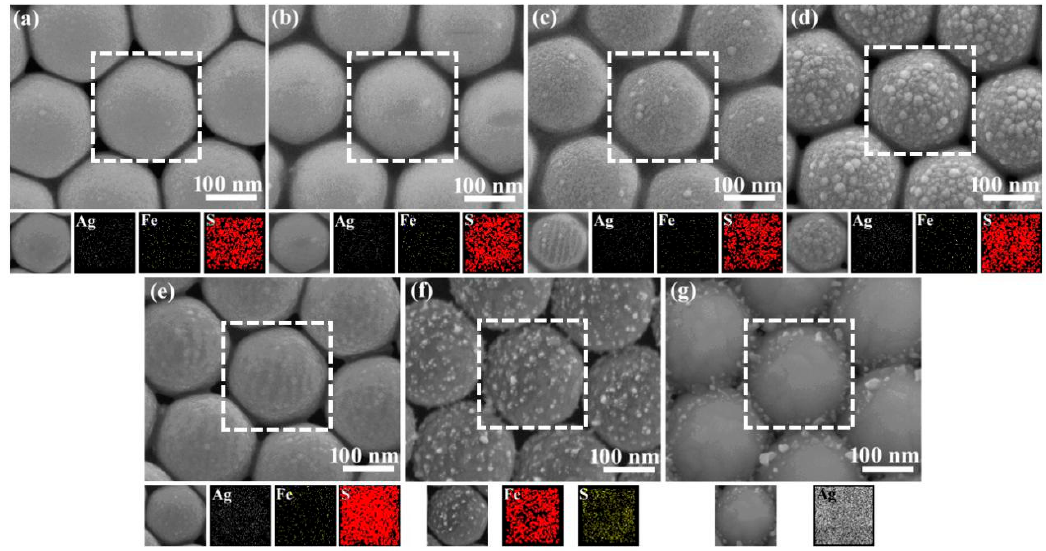
Figure 1. SEM images of the ordered Ag-FeS arrays, which were prepared by cosputtering Ag with a constant sputtering power (5 W) and FeS with varied sputtering powers for 300 s on the PSCP templates. The sputtering powers of FeS were ( a ) 50 W, ( b ) 60 W, ( c ) 70 W, ( d ) 80 W and ( e ) 90 W; sputtered pure FeS ( f ); and pure Ag ( g ) for 300 s.